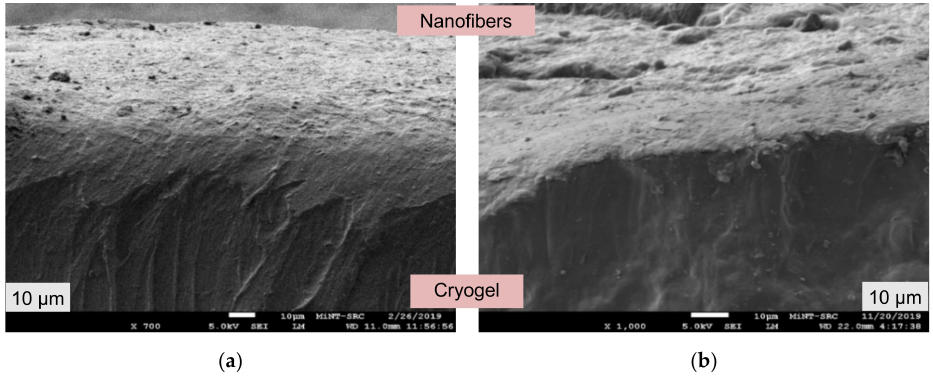
Figure 3. Cross-section of prepared dual layer P VA patches, ( a ) DL A 3C and ( b ) DL B 3C.